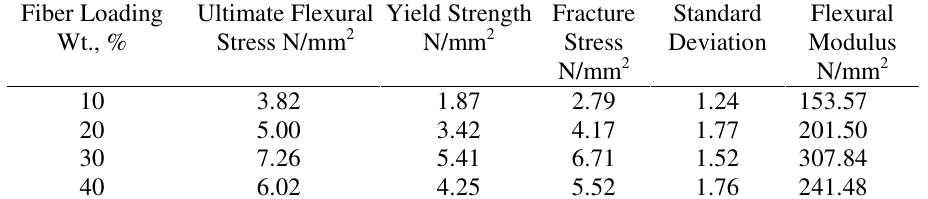
Table 3. Parameters from flexural stress-strain curve for different percentage